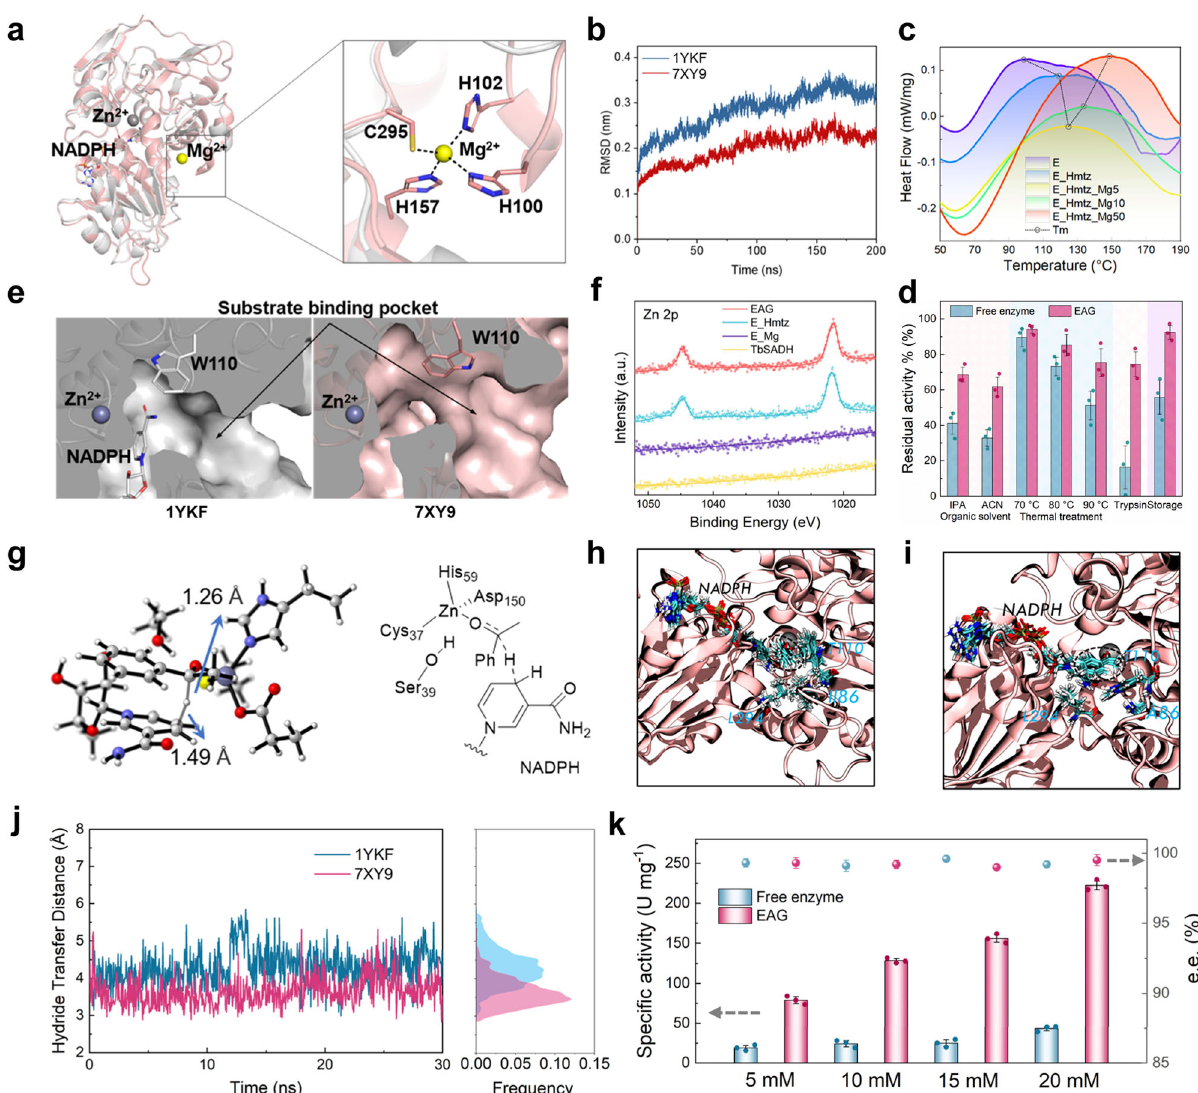
Fig. 6 | Structural analysis of the differences in enzyme activity and stability before(1YKF)andafter(7XY9)gelation.a Overlayofthe7XY9(salmon)and1YKF (gray) structures. Inset shows the coordination of the Mg 2+ ion with the adjacent residues. Dashed lines indicate the distances between the Mg 2+ ion and coordina- tionatomsofH102,C295,H157,andH100,whichareequalto2.2,2.3,2.0,and2.4Å, respectively. b RMSD values of 1YKF and 7XY9 obtained via high-temperature simulations. c DSC curves showing the thermostability of E, E_Hmtz, and EAG synthesizedatdifferent c (Mg 2+ )values. d Residualactivitiesofthefreeenzymeand EAG measured after the exposure to an organic solvent (30% IPA or ACN, 2h), thermal treatment (1h), proteolytic agent treatment (trypsin, 3h), and storage for